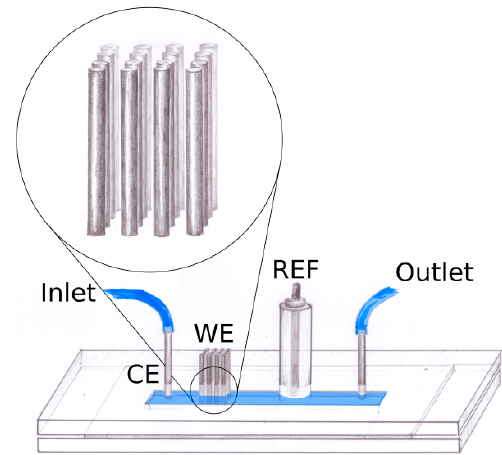
Figure 2. Schematic drawing of the device, CE—counter electrode, WE—working electrode, RE— reference